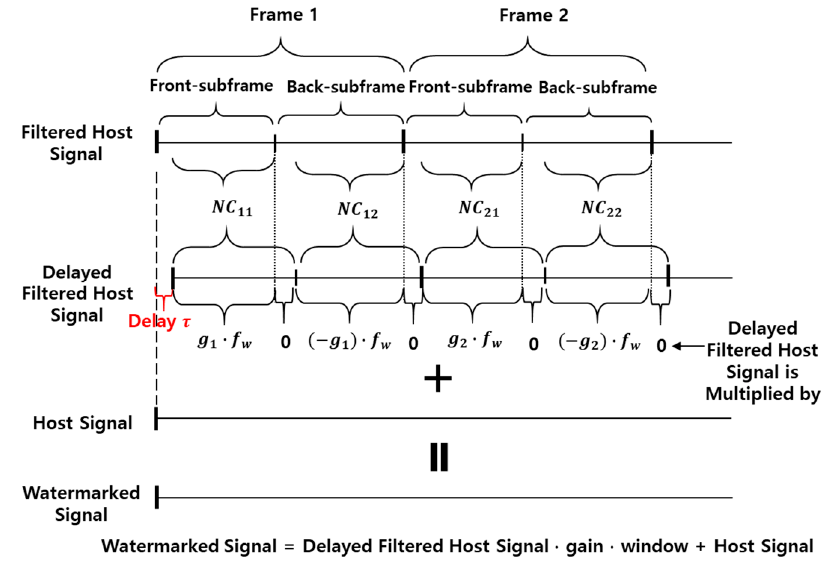
Figure 4. Watermark embedding diagram.